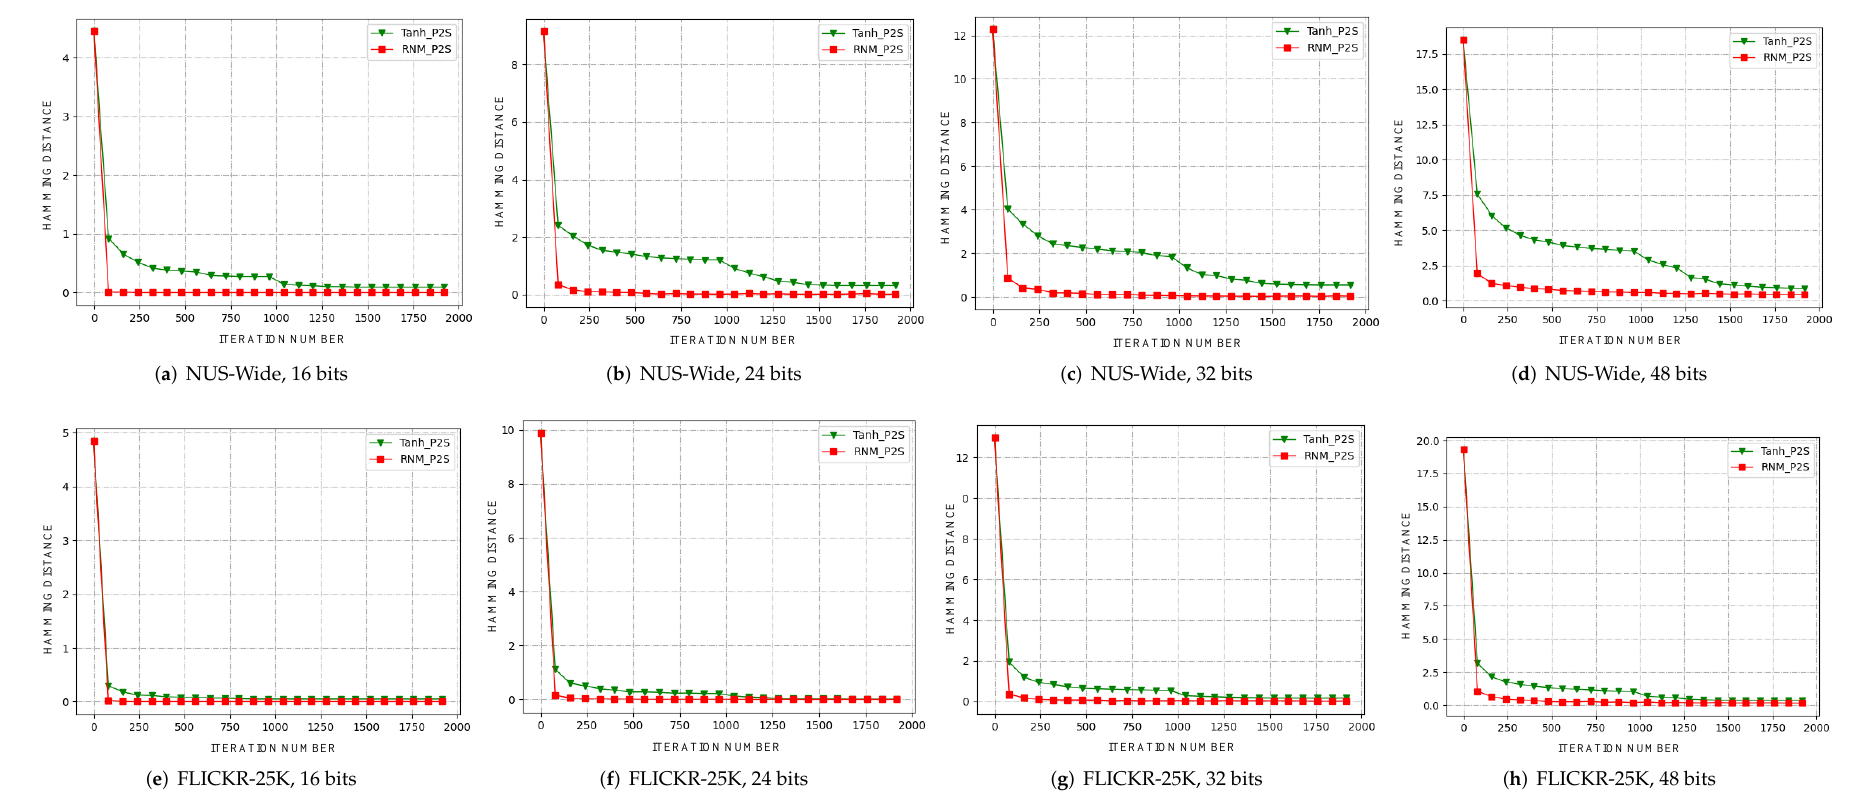
Figure 2. The value of the Hamming distance in the 2000-iteration optimization process under two datasets with 16, 24, 32, 48 bits. The green straight line is the Tanh-P2S method with anchor code, and the red dotted line is our